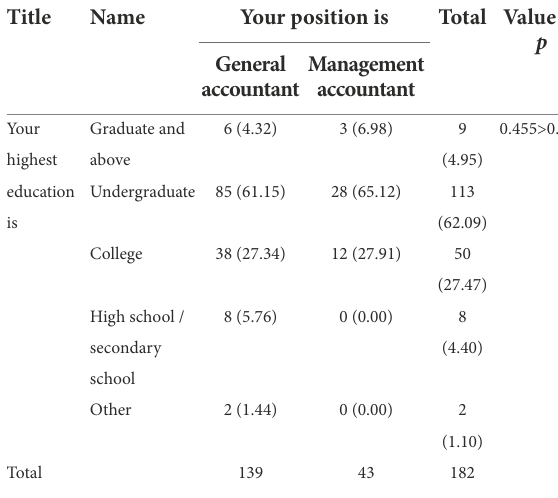
TABLE 6 The results of the cross (Chi-square) analysis of educational background and job